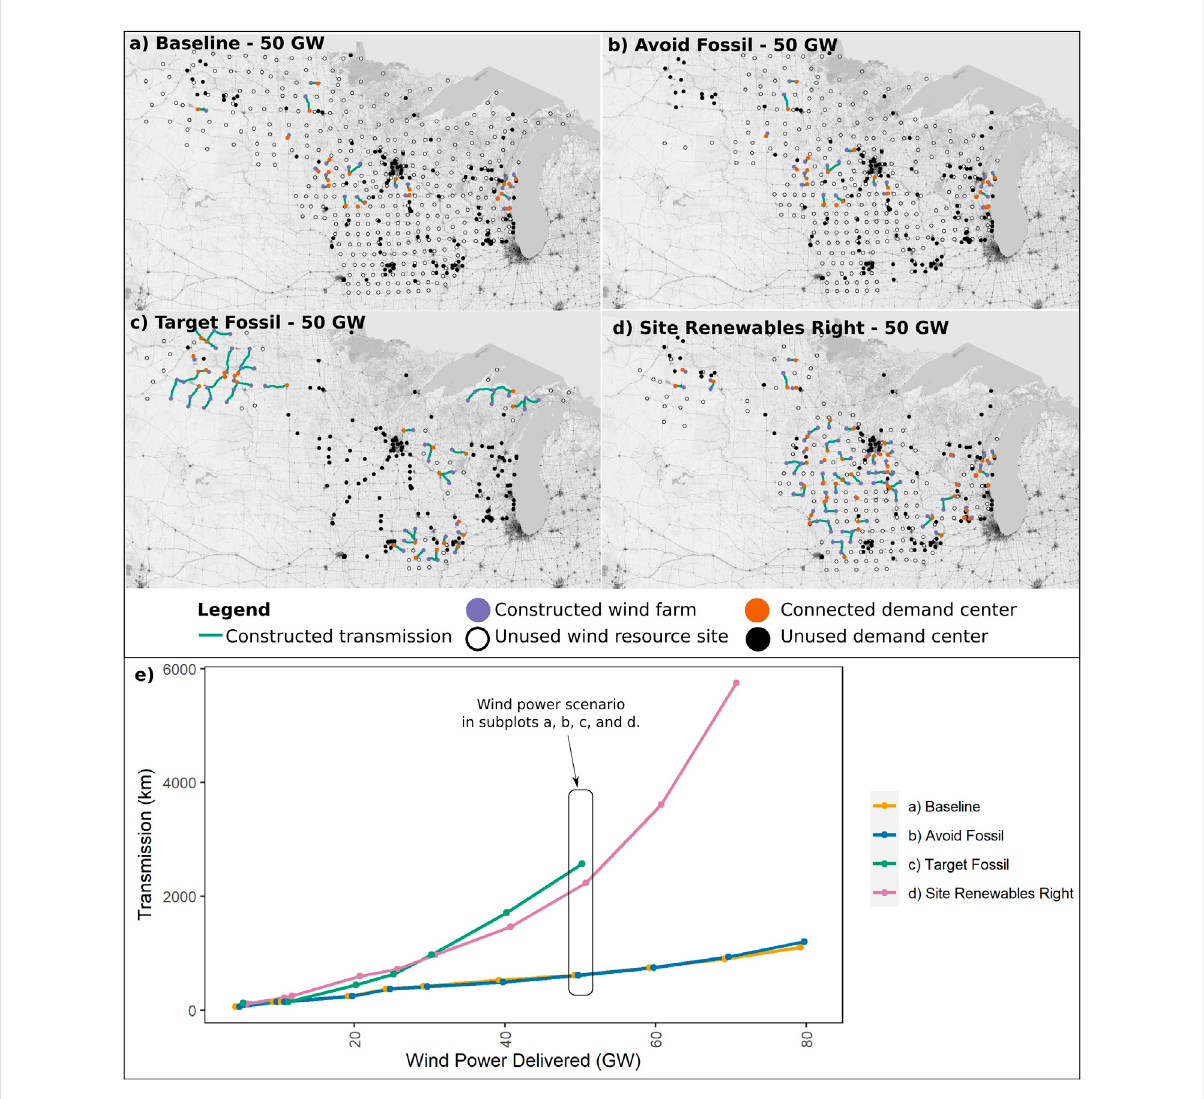
FIGURE A1 Comparison of networks using substations as grid connection points at 50 GW power delivered for (A) baseline, (B) avoiding fossil fuel communities, (C) targeting fossil fuel communities, (D) Site Renewables Right against the (E) transmission build-out for each